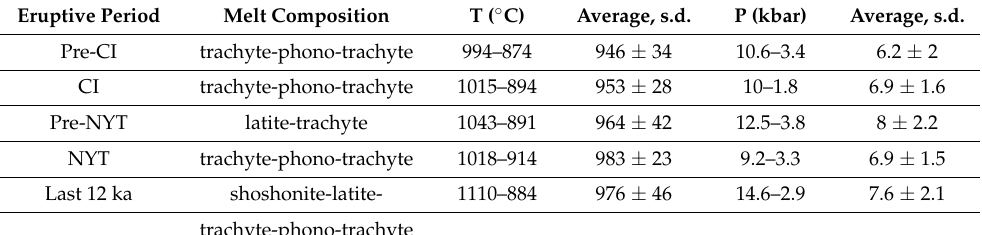
Table 3. Temperature and pressure output obtained from the Putirka [13] geothermobarometers applied to clinopyroxene-melt couples whose equilibrium has been verified with equilibrium test 1. Eruptive